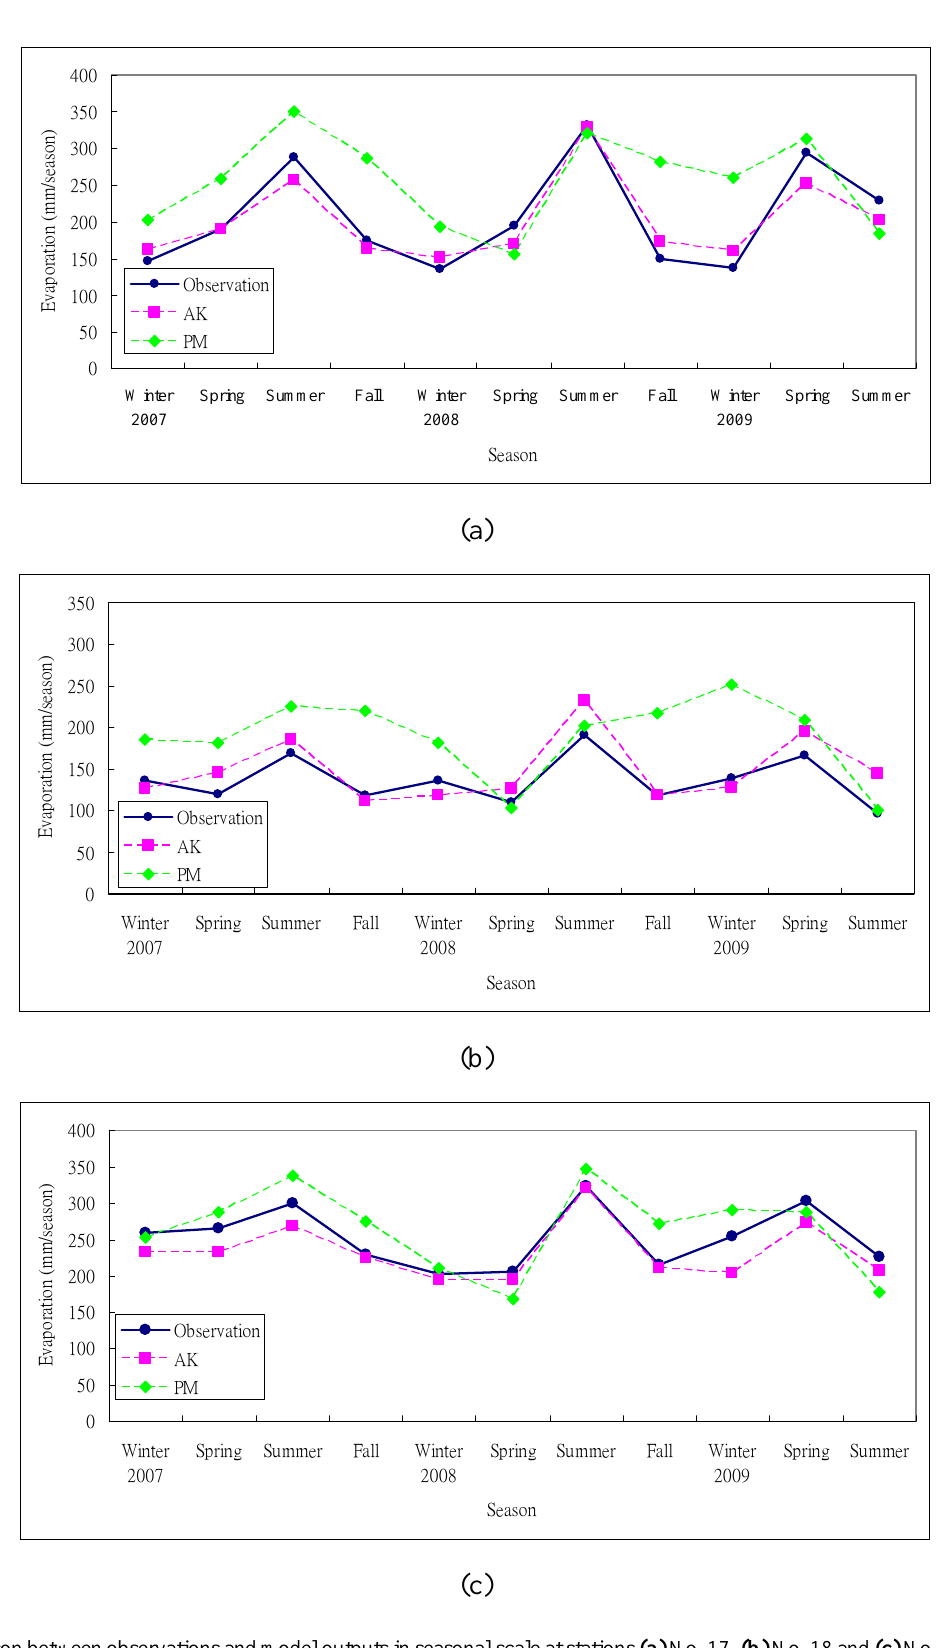
Fig. 7. Comparison between observations and model outputs in seasonal scale at stations (a) No. 17, (b) No. 18 and (c) No. 19 (three assumed ungauged sites).